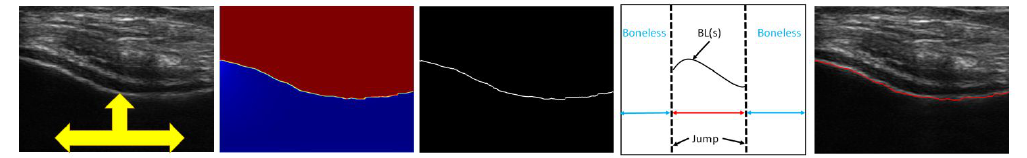
Figure 5. Bone-surface localization. ( a ) In vivo B-mode US knee scan. Yellow arrow, bone-shadow region. Enhanced bone-shadow image BSE ( x , y ) . Soft-tissue interface, red color. Bone-shadow regions, blue. Intensity values depict the probability of a signal reaching the transducer imaging array if the signal propagation started at that specific pixel location. The transition region between the soft-tissue and bone-shadow regions represent the expected bone-shadow interface. ( b ) Bone probability image. ( c ) Bone, boneless, and jump regions. ( d ) Localized bone surface, shown in red, overlaid on original B-mode US